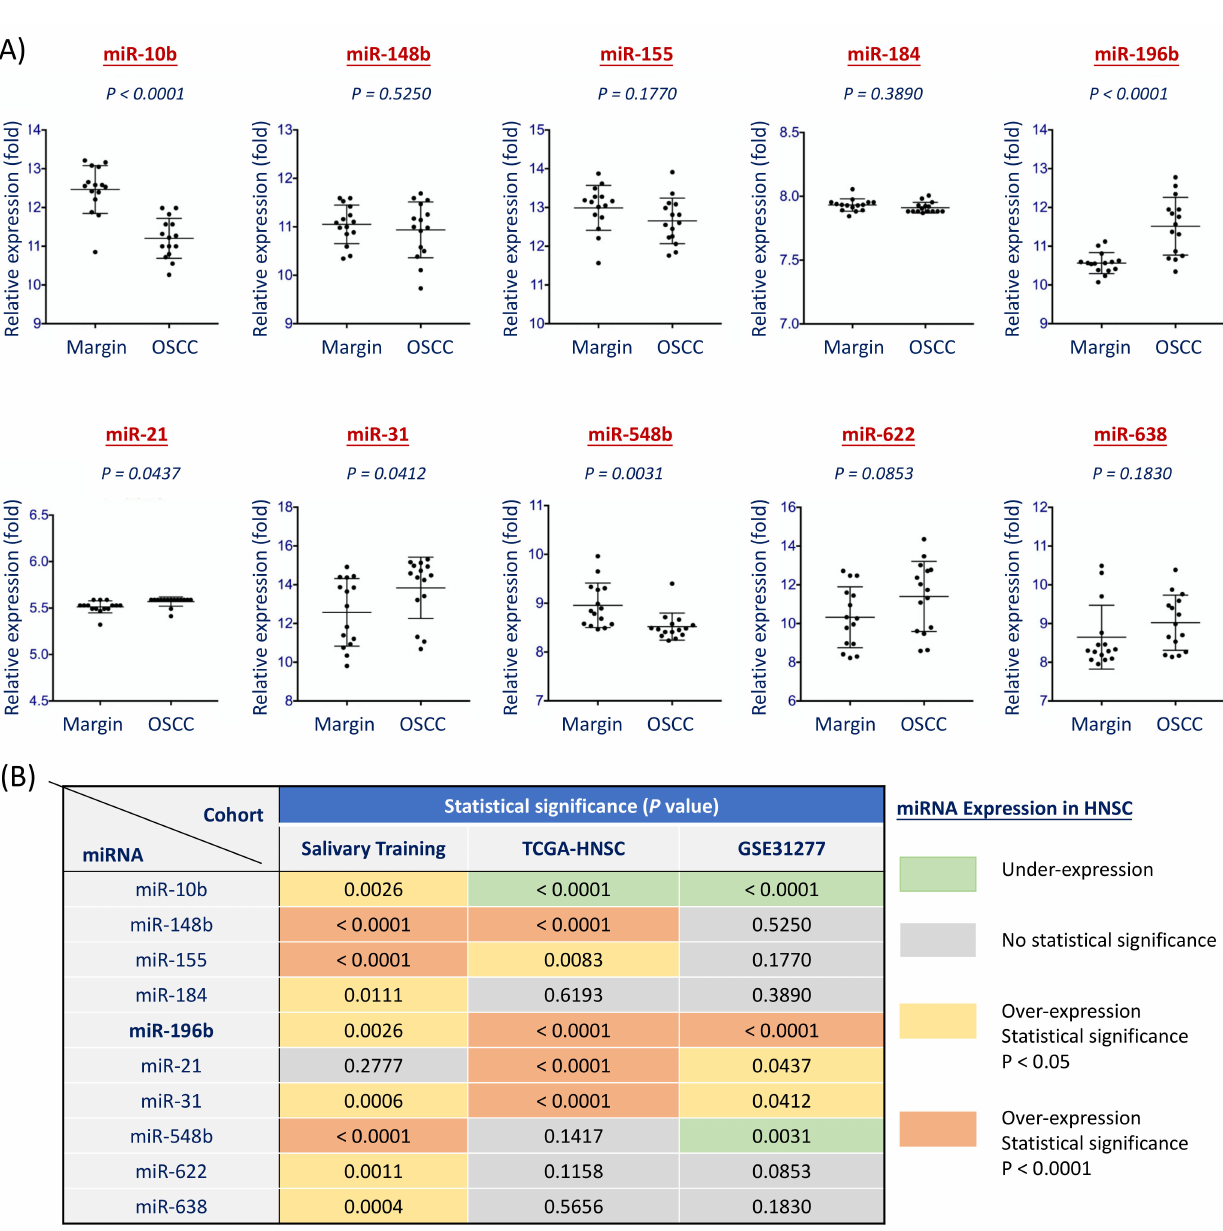
Figure 4. Examination of the 10 miRNA levels in the tumor and normal tissues from the GSE31277 dataset. The Gene Expression Omnibus (GEO) online software was used to determine the relative levels of the 10 miRNAs (miR-10b, miR-148b, miR-155, miR-184, miR-196b, miR-21, miR-31, miR-548b, miR-622, and miR-638) from the GSE31277 miRNA cohort. This GSE31277 dataset comprised 15 tumors and the surgical removed marginal normal tissues from HNSC patients. The relative expression level with (fold) was presented, after comparison with the signaling intensity of each data point in the Illumina miR array used in the GSE31277 cohort. ( A ) The expression levels between tumors and normal groups of each miRNA. ( B ) The overall results of the 10 miRNAs were assessed by three independent cohorts. The p -values presented the efficacy of each miRNA distinguishing between normal versus cancer